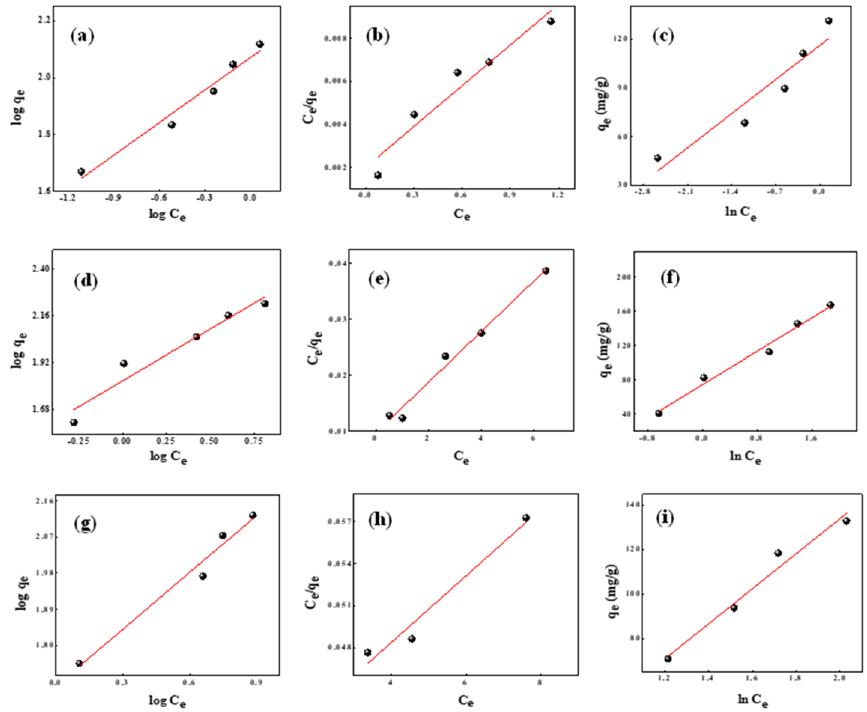
Figure 8. ( a – c ) Freundlich, Langmuir and Temkin isotherm plots for BG; ( d – f ) Freundlich, Langmuir and Temkin isotherm plots for MG; ( g – i ) Freundlich, Langmuir and Temkin isotherm plots for CR dyes. Table 2. Isotherm constants and correlation coefficients obtained for BG, MG and CR dyes.